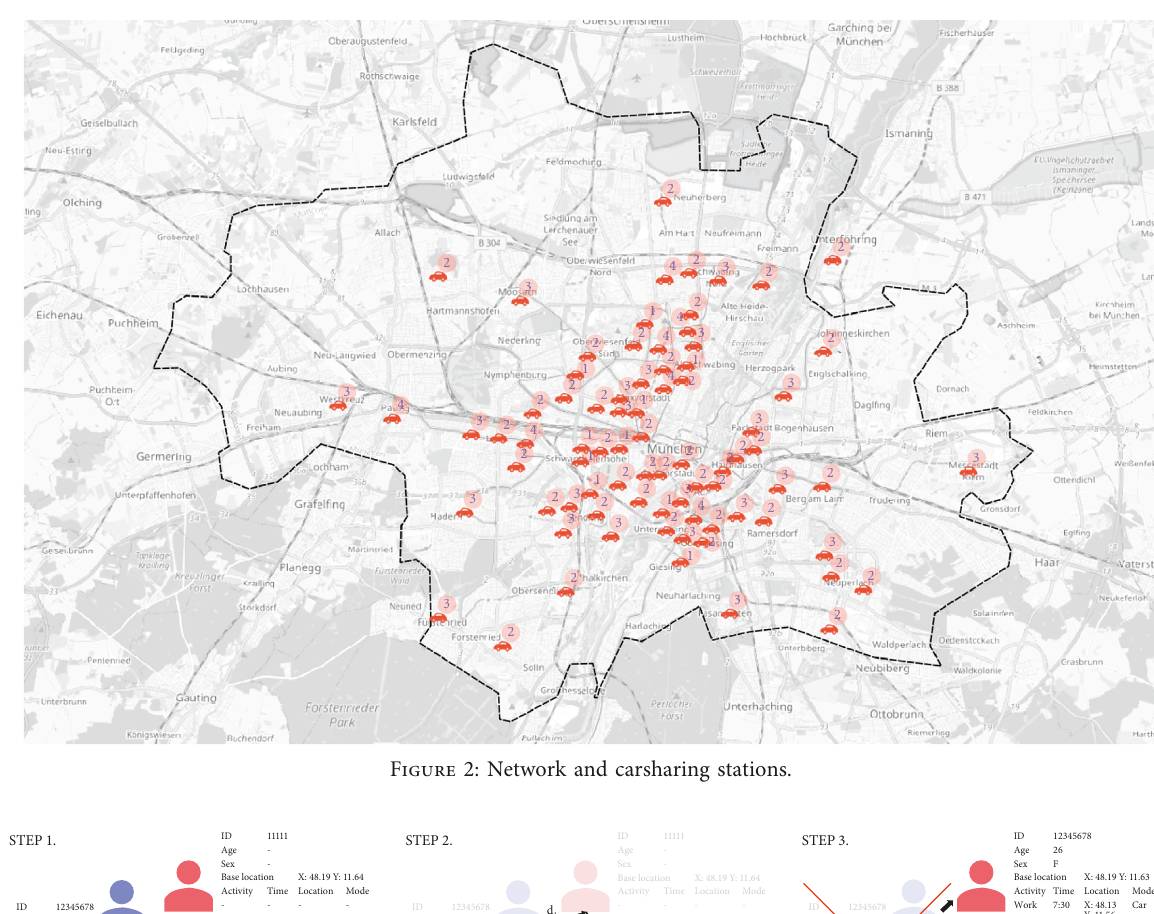
Figure 2: Network and carsharing stations.